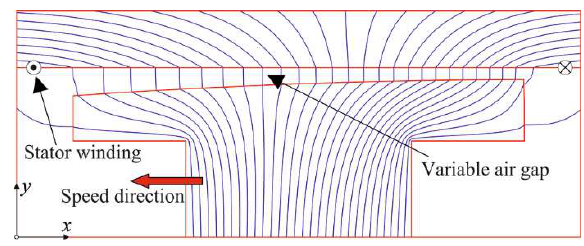
Figure 3. Magnetic salient pole suitable for fast rotating SM.